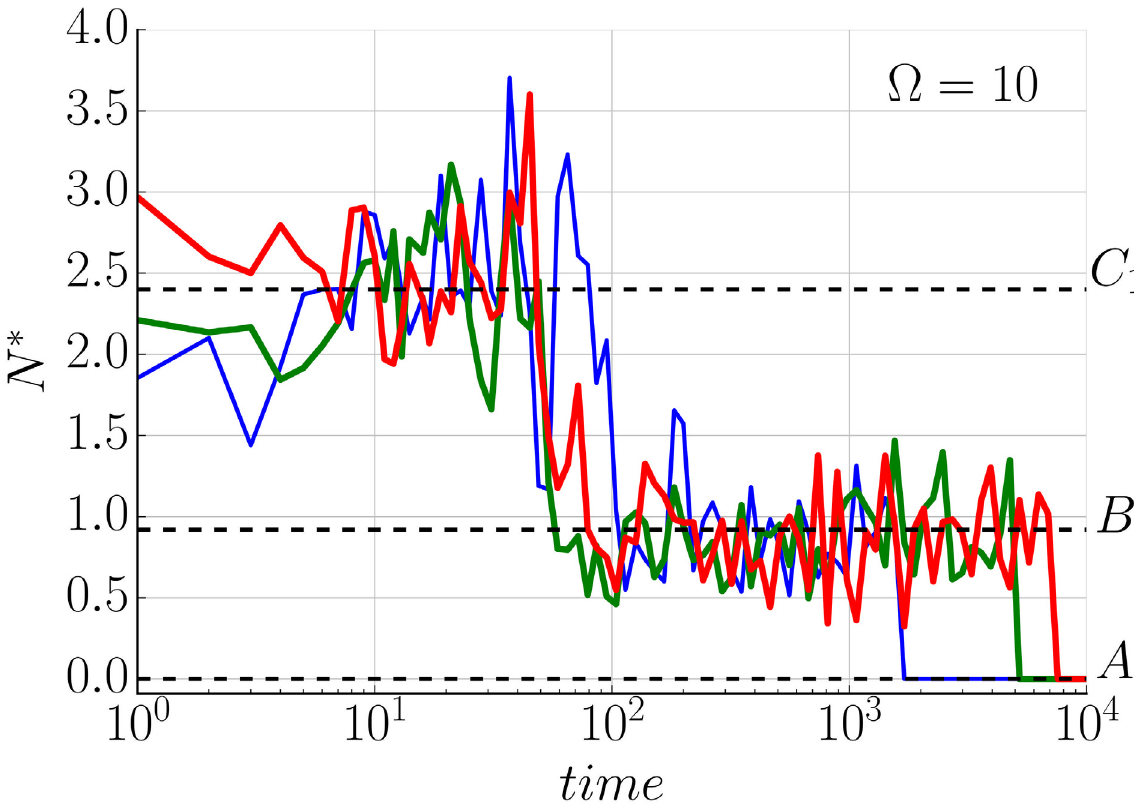
Fig 8. Noise can change the morphology of the tumour over time. Three Langevin trajectories showing a stable tumour becoming avascular and finally disappearing (each trajectory fluctuates around the steady state C 3 then jumps to the vicinity of B trapped in the set of states ( N , P , 0) and finally is absorbed by A ). Initial condition and parameters are those of Fig 3, Ω =